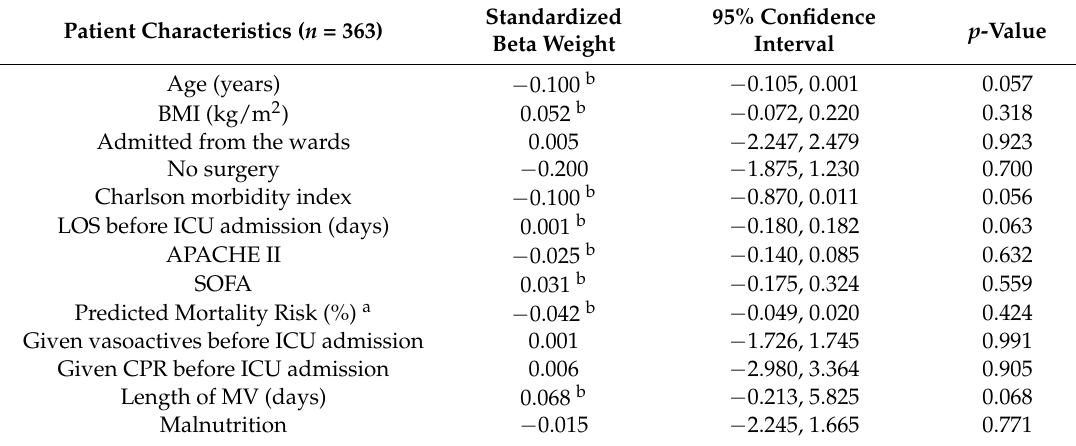
Table 3. Simple linear regression models of the association between patient characteristics and length-of-stay in the Intensive Care Unit (measured in days) amongst patients who were discharged alive from the Intensive Care